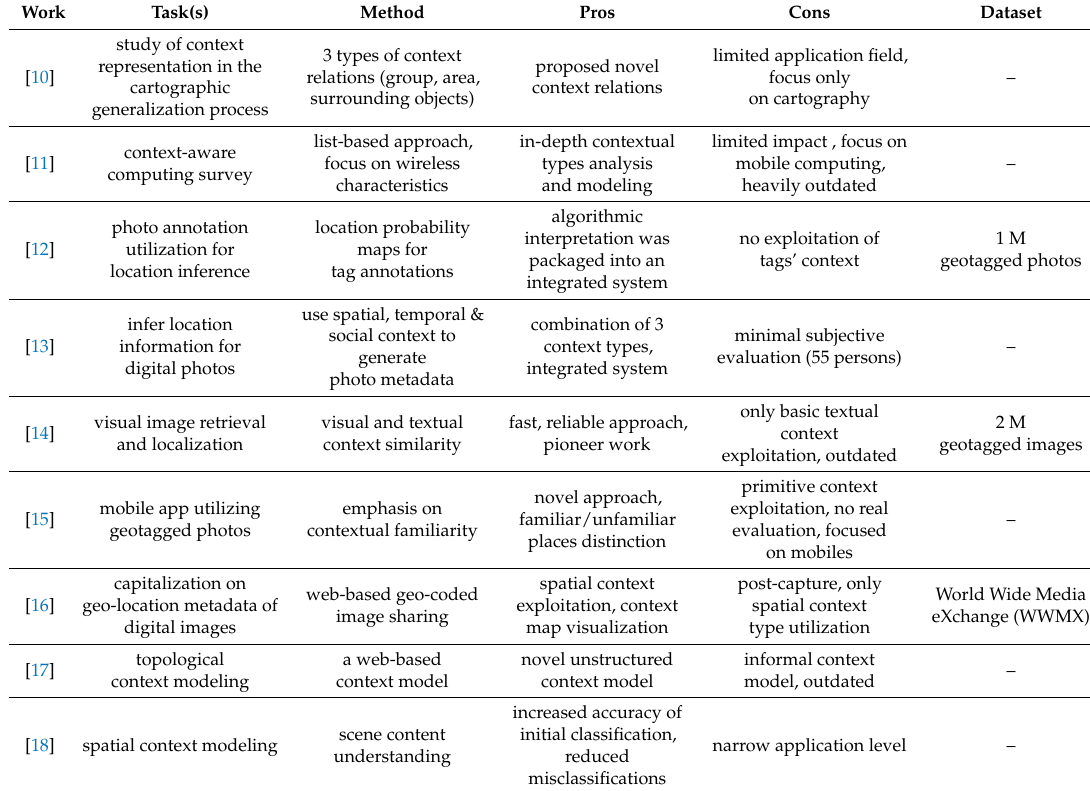
Table 2. Topological context